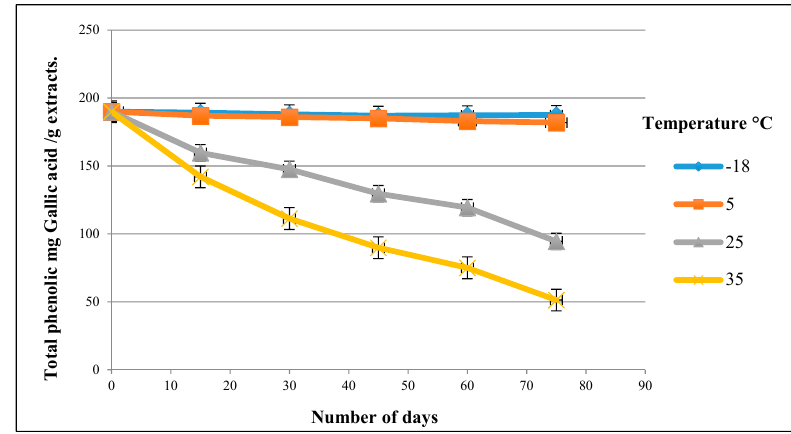
Figure 2. Stability of the olive leaf extract at different temperatures over a period of 75 days.